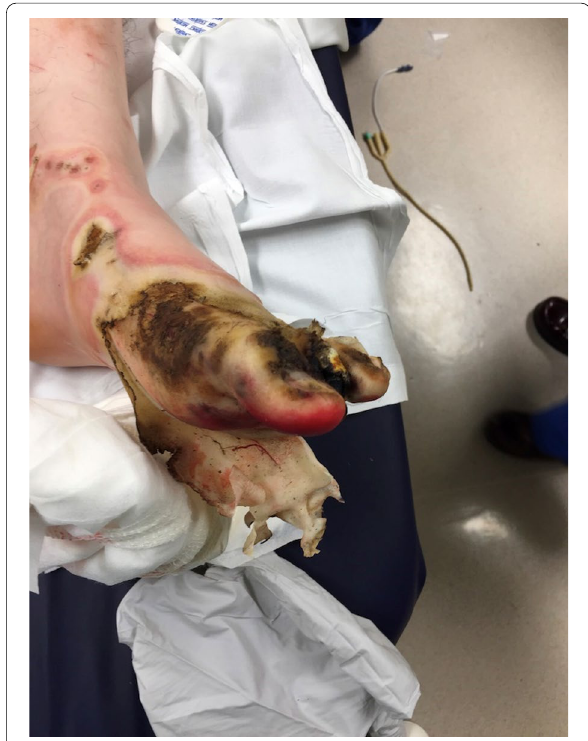
Fig. 4 Left lower extremity full-thickness electrical burn with distal necrosis